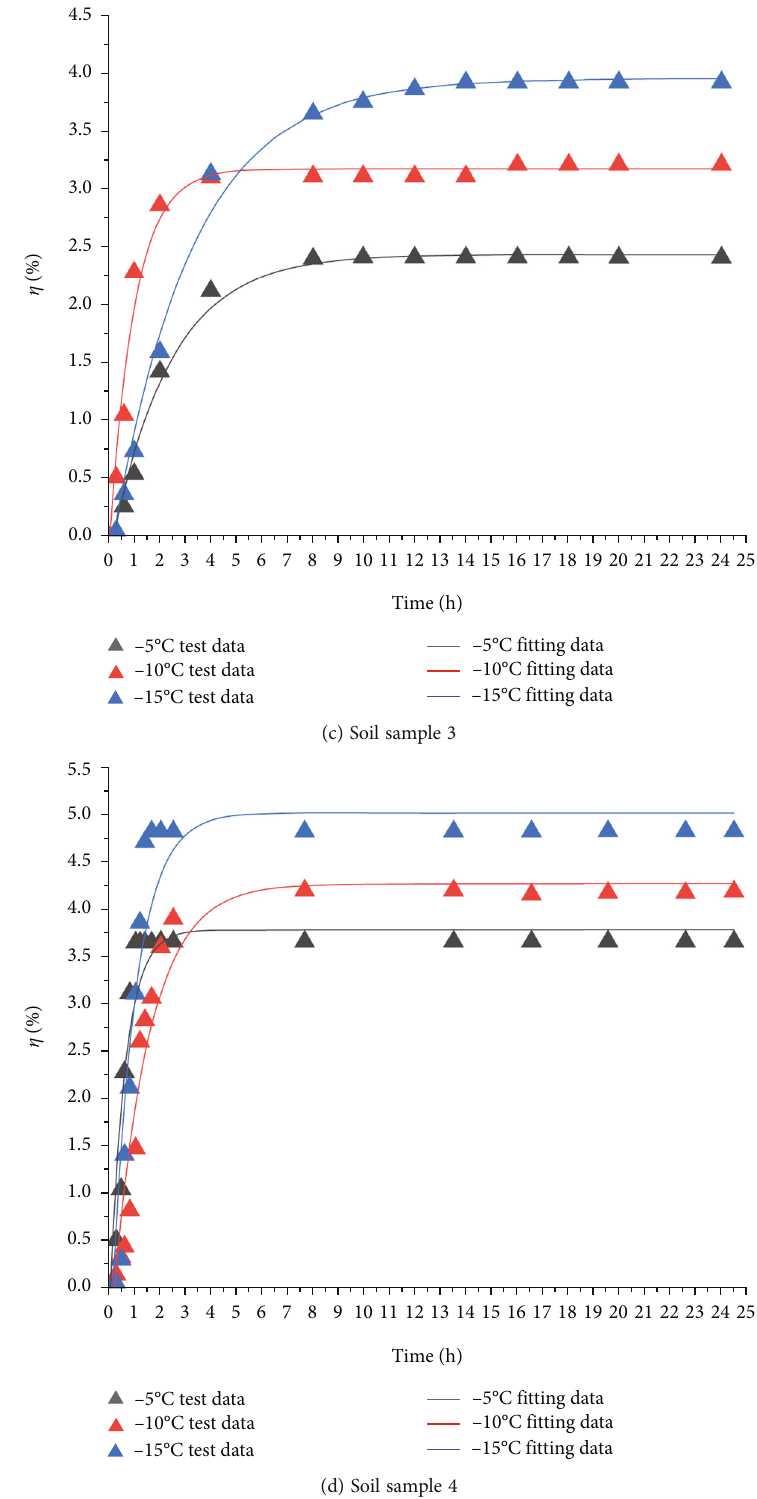
Figure 4: Relation curve between frost heaving rate and